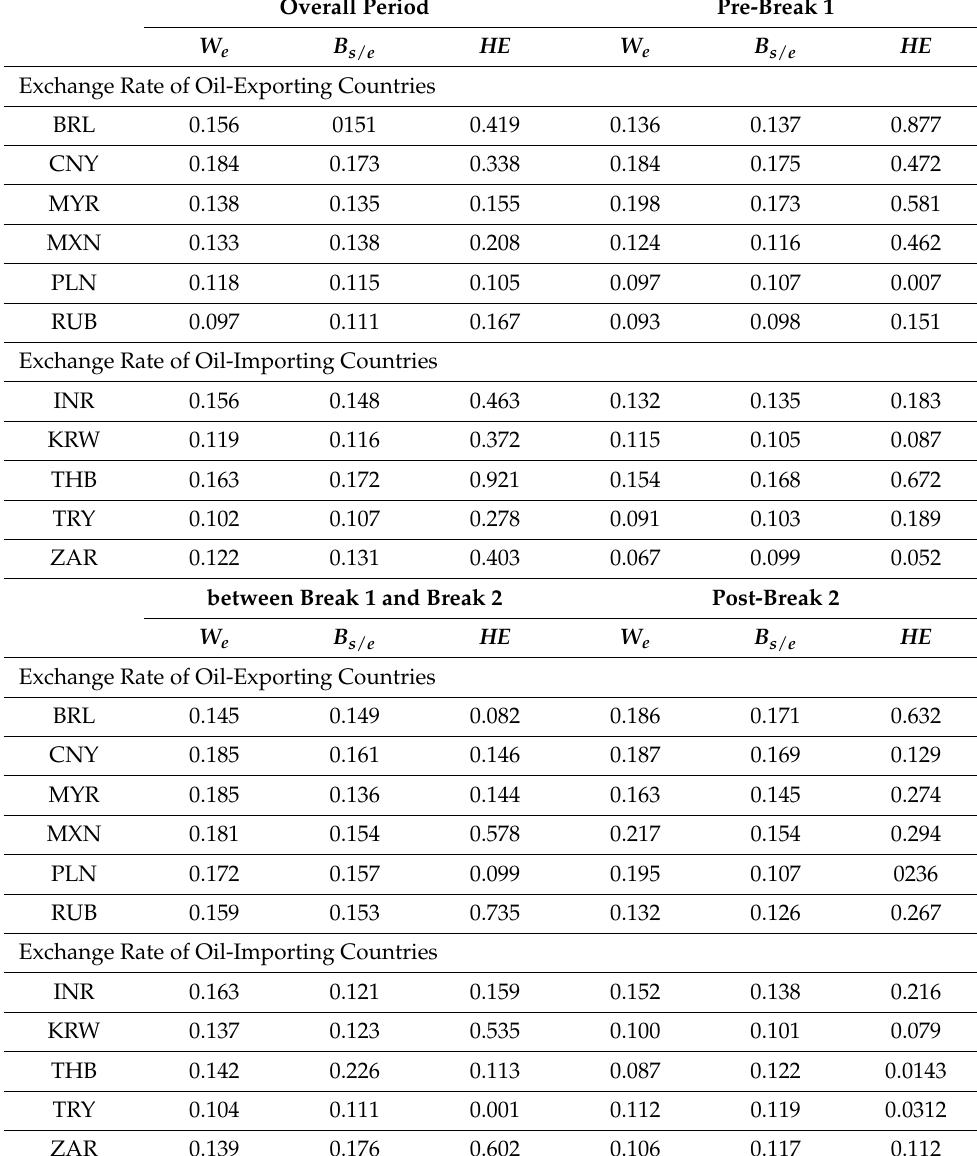
Table 8. The average values of the optimal weight, hedge ratio, and hedge